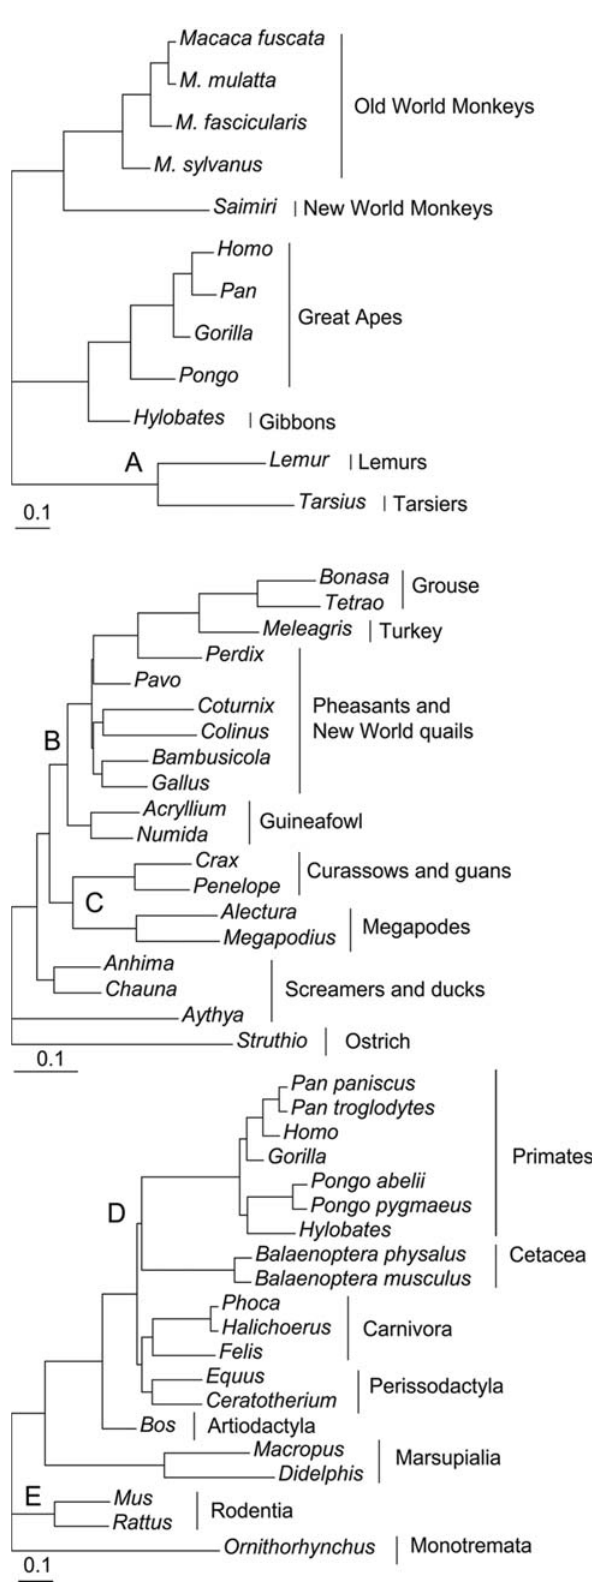
Figure 3 - Shortest unrooted phylogenetic trees recovered by the ABPR algorithm. Nodes marked A to E are incongruent with current views of phylogenetic relationships based on molecular data and are discussed in